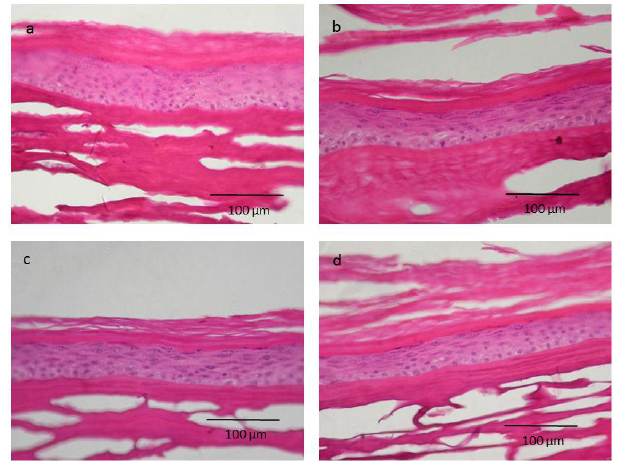
Figure 5. Episkin histological images. Tissues were processed for paraffin sections and stained with hematoxylin and eosin stain for histological examination. Normal control group treated with PBS ( a ), ZnO non-nanometric ( b ), ZnO 50 nm ( c ) and ZnO 100 nm ( d ).